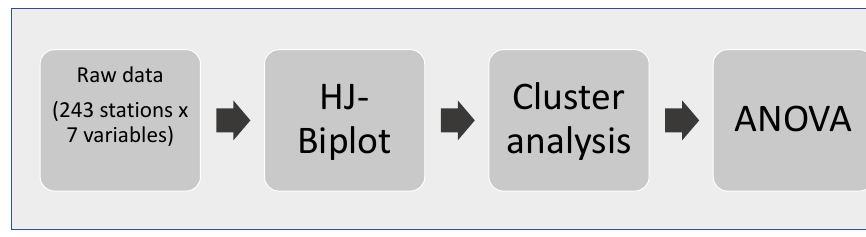
Figure 3. Flowchart of the